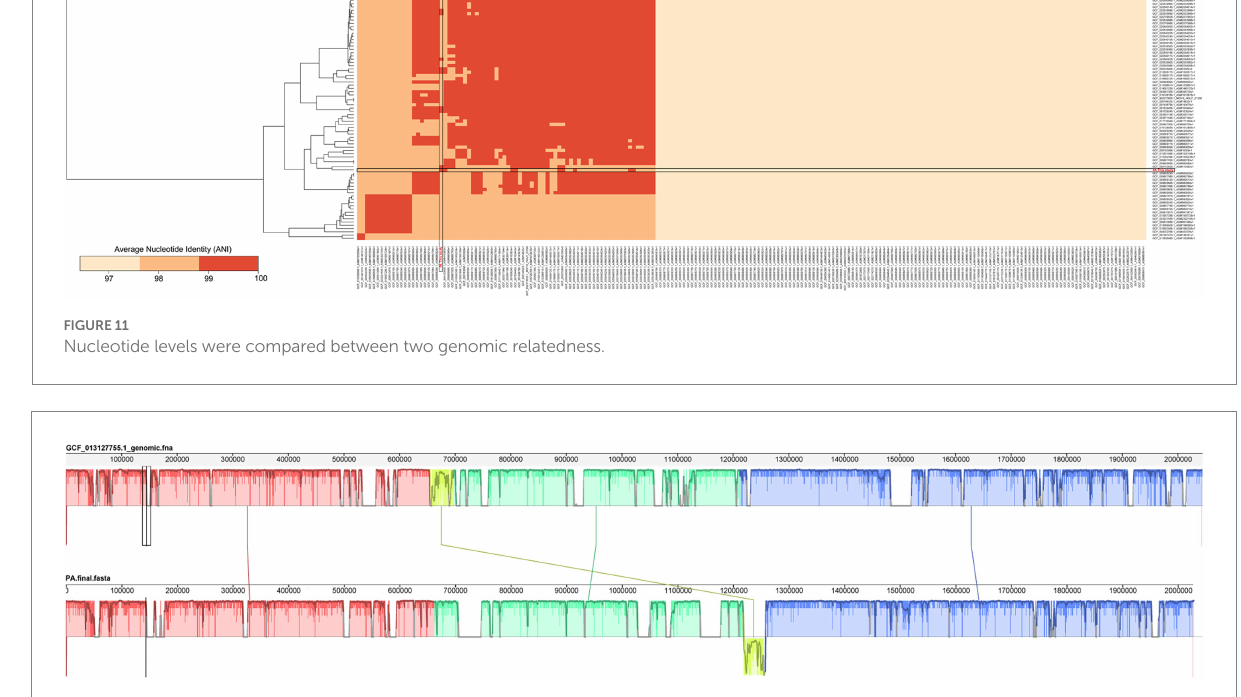
FIGURE 12 Collinearity analysis of Pediococcus acidilactici and